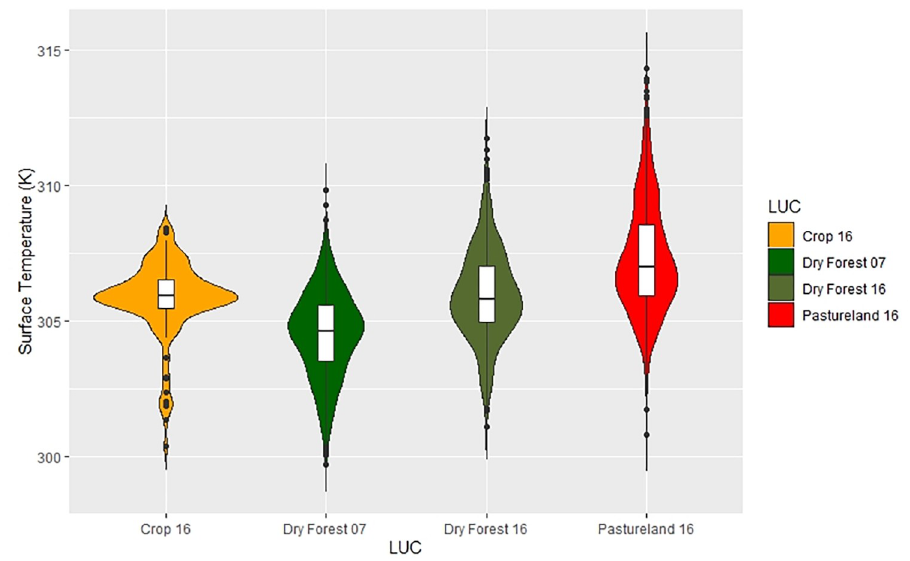
Fig 4. Boxplot of surface temperature (ST) considering the annual average (from the years 2007 and 2016) for the analyzed land uses and land cover.